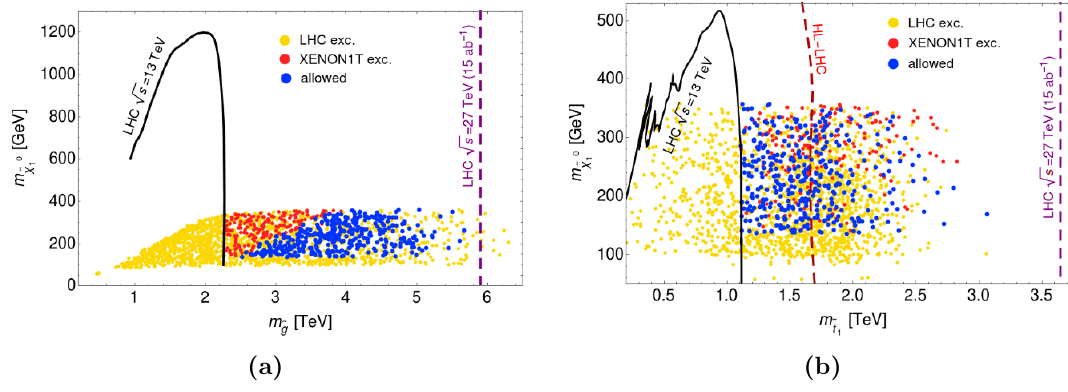
Figure 5. Locus of n = 1 landscape scan points for the NUHM3 model with (cid:22) = 100{360 GeV in the (a) m vs. m ~ g and (b) m vs. m ~ planes versus recent LHC Run2 t 1 e (cid:31) 0 1 e (cid:31) 0 1